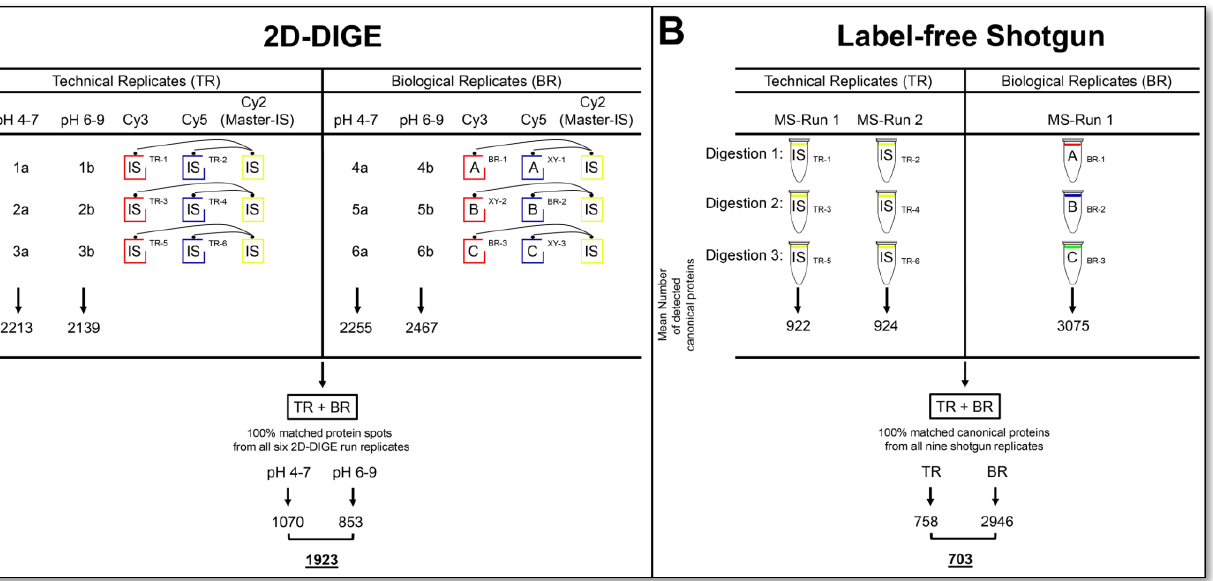
Figure 1. Experimental design and workflow for comparative proteome and proteoform analysis. ( A ) Schematic representation of 2D-DIGE workflow and consistently (100%) matched protein spots (proteoforms) in technical and biological replicates. ( B ) Schematic representation of label-free shotgun workflow and consistently (100%) identified canonical proteins in technical and biological replicates. Detailed statistics on the frequency of the detected protein events are summarised. Abbreviations: TR — technical replicate; BR — biological replicate; IS — internal standard; MS — mass spec- trometry.